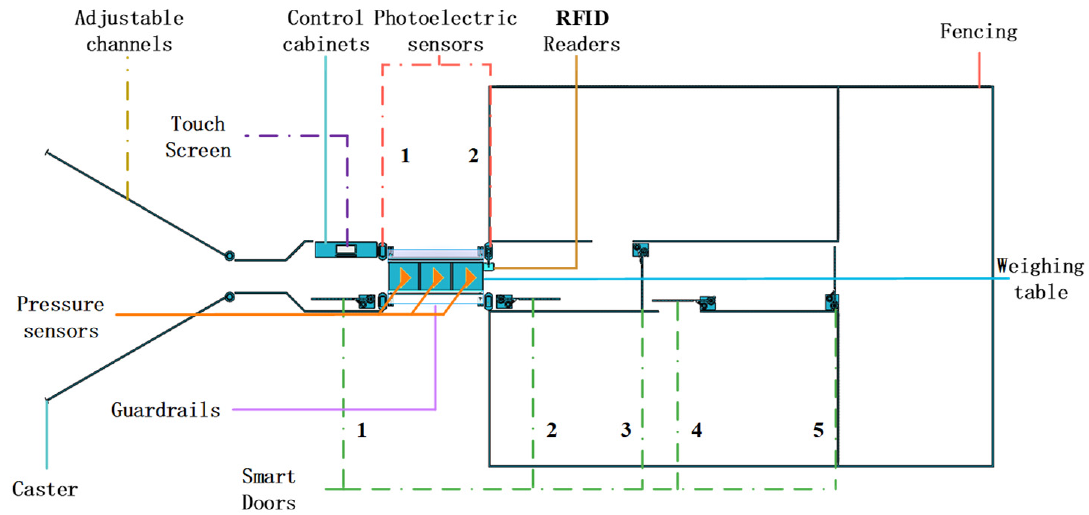
Figure 3. Top view of the system.